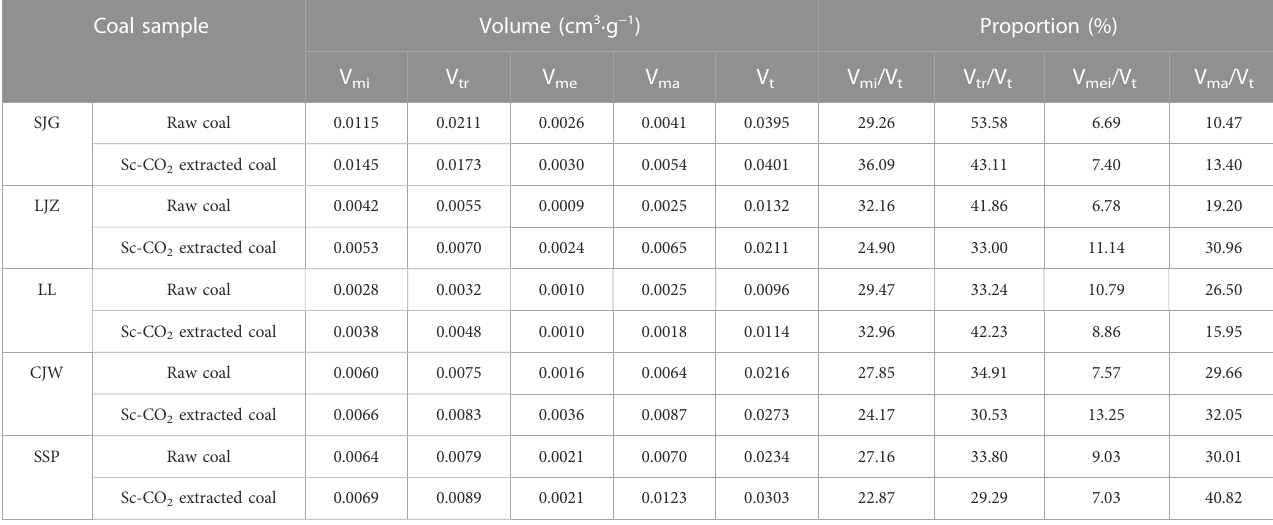
TABLE 2 Pore volumes of the samples before and after the Sc-CO 2 extraction. Coal